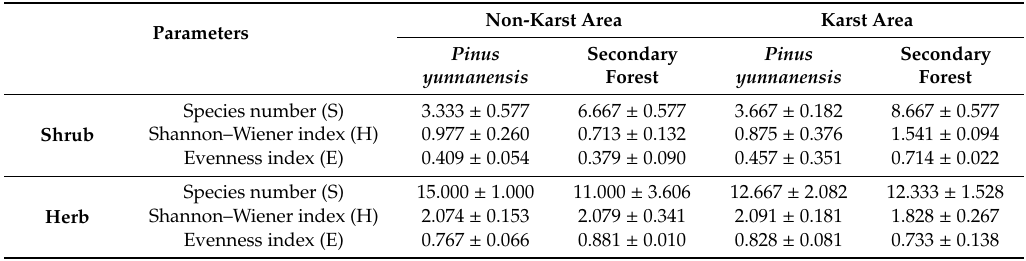
Table 1. Basic characteristics of plant communities in non-karst and karst areas in southern China. The results are shown as the mean ± standard errors (SE). The same